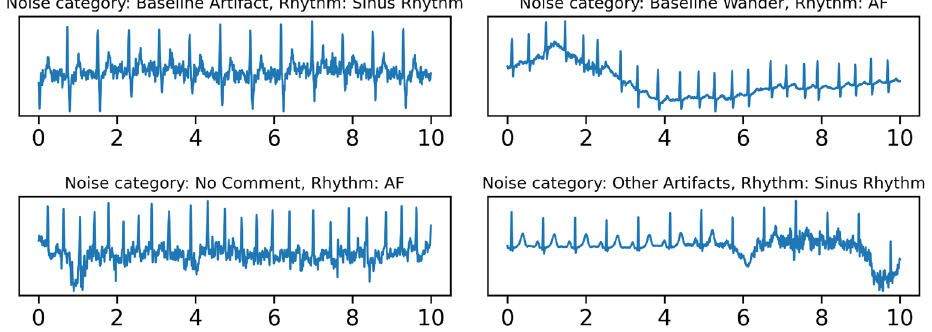
Figure 5. Example, unprocessed segments demonstrating different types of noise in the labelled KGH dataset. “No comment” indicates that while a record was identified to be noisy, there was no specific definition or terminology that clearly applied to the type of noise present. Only lead I is shown.